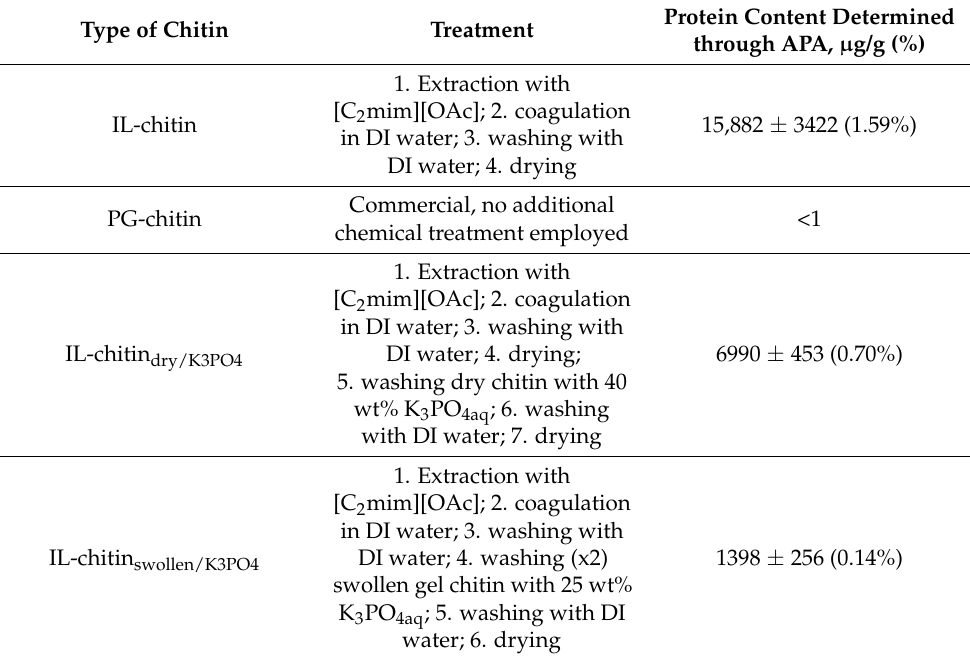
Table 1. Treatment of IL-chitin (wet and gel form) with K 3 PO 4 and APA analyses